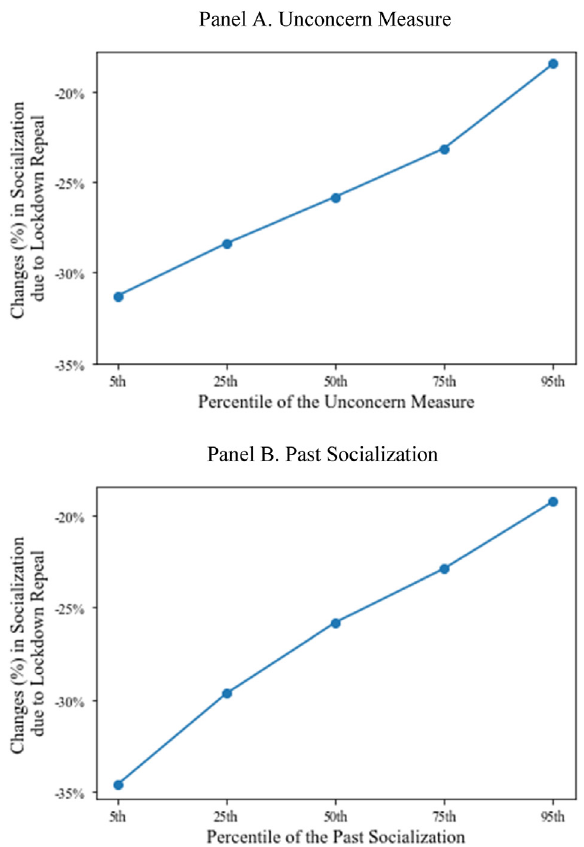
Fig. 2. Moderating effect of lockdown repeal. Panel A. Unconcern measure. Panel B. Past